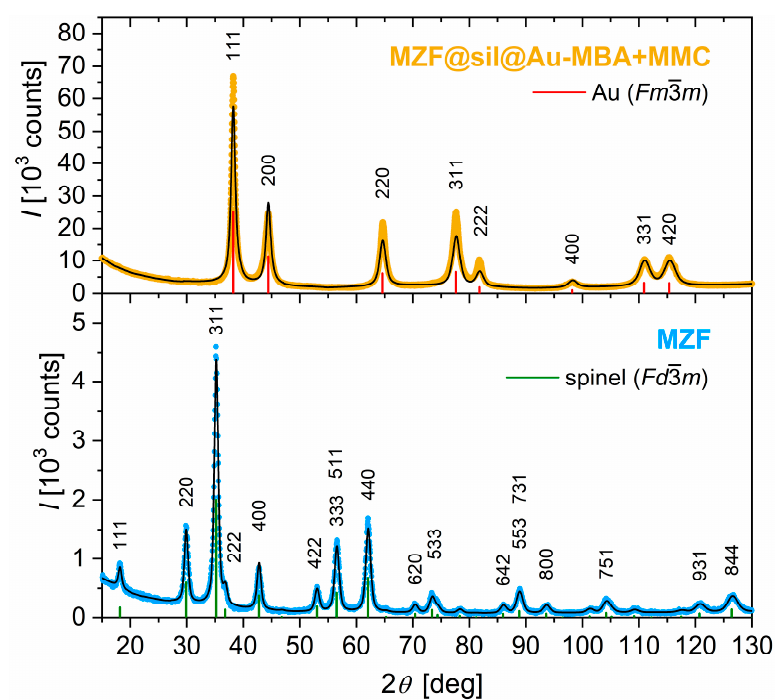
Figure 1. Powder XRD patterns of the starting Mn 0.61 Zn 0.42 Fe 1.97 O 4 nanoparticles (MZF) and the final organically functionalized gold nanoshells with silica-coated ferrite cores (MZF@sil@Au- MBA+MMC). The measured data are complemented with the calculated patterns (black lines) based on the Rietveld refinement of the spinel ( Fd 3 m ) and gold ( Fm 3 m ) structures (original structure data retrieved from the Inorganic Crystal Structure Database under the collection codes 98553 and 64701). The diffraction lines of the refined structures are depicted by green and red verticals,